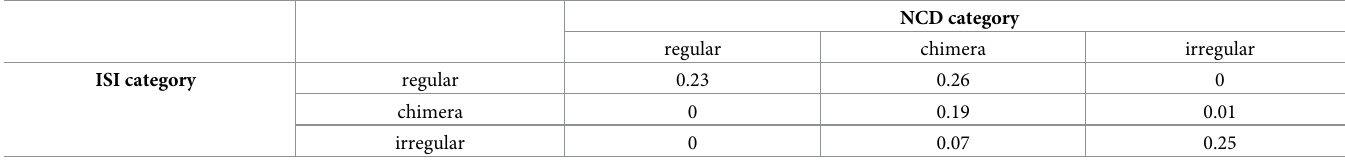
Table 3. Network state classification by ISI statistics and NCD values in Newman-Watts-Strogatz network